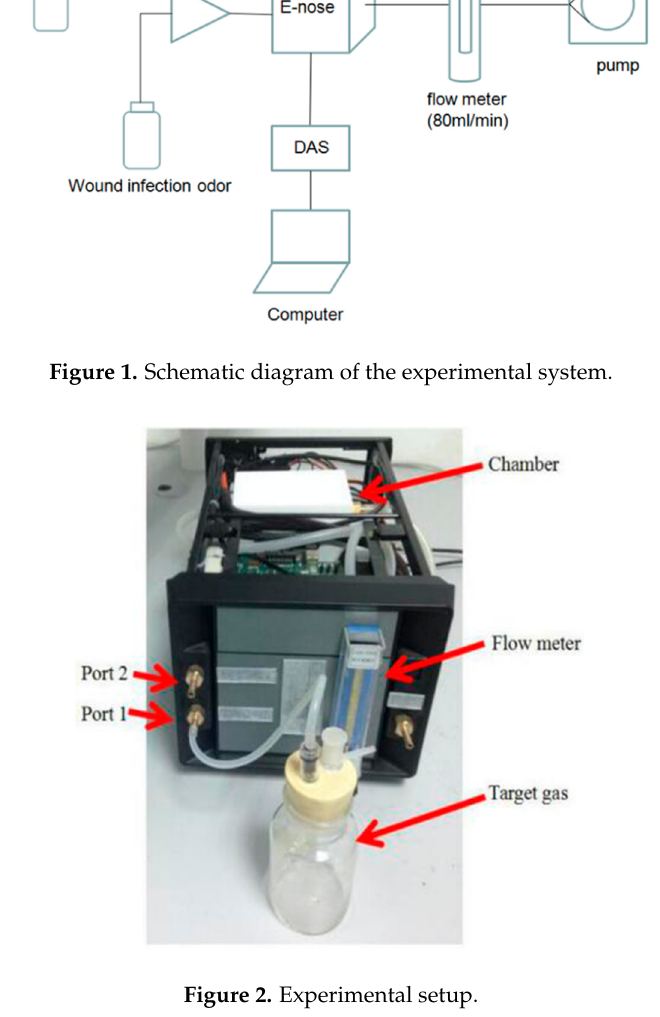
Figure 2. Experimental setup.